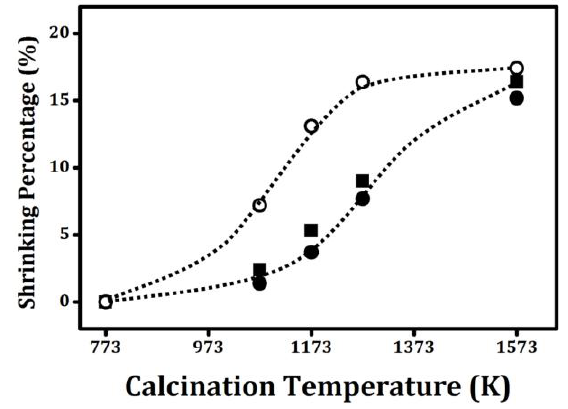
Figure 3. Shrinkage of ceramic wafers as a function of calcination temperature: ( ○ ) Unmodified ZrO 2 ; ( ■ ) 20 CeO 2 /ZrO 2 ; (●) 20 ZrO 2 /ZrO 2 . The original diameters for all the pellets were 1.495 cm.